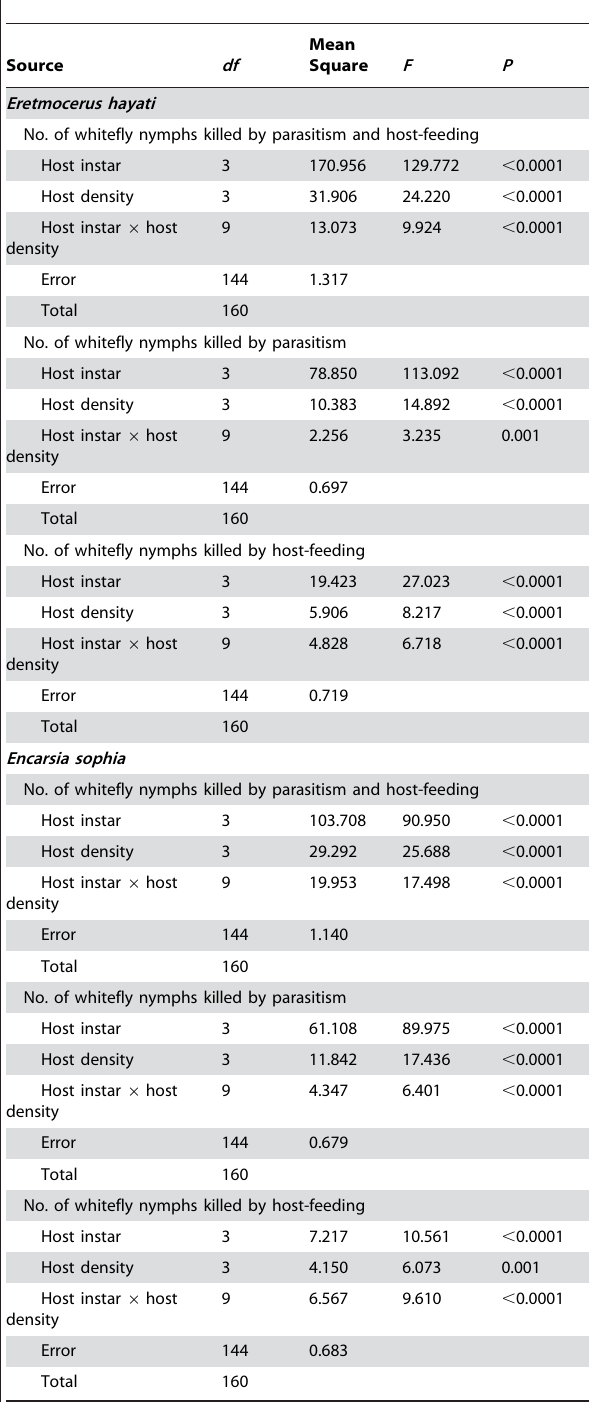
Table 1. The results of ANOVA of whitefly host instar and host density for parasitoids.